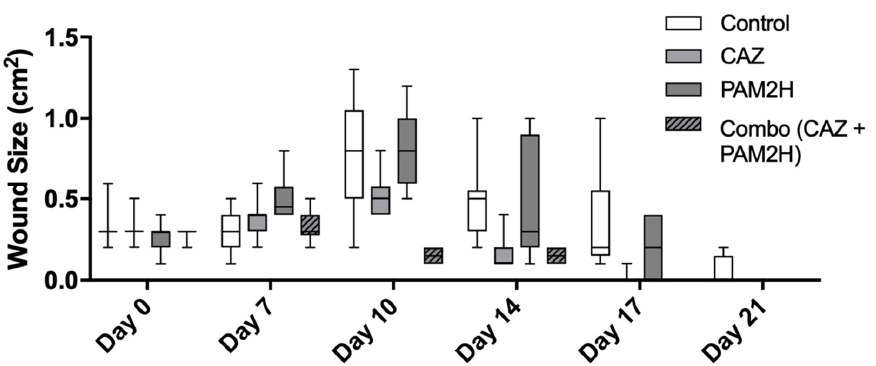
Figure 4. Mouse dorsal wound sizes as measured by an Aranz wound measurement device over 21 days. On day 10, the wound size for the combo-treated group was significantly smaller than that in the control or in the other treatment groups ( p < 0.005), and the median wound size on day 10 for the combo group was less than the median wound size on day 0, meaning the wounds had begun to contract and